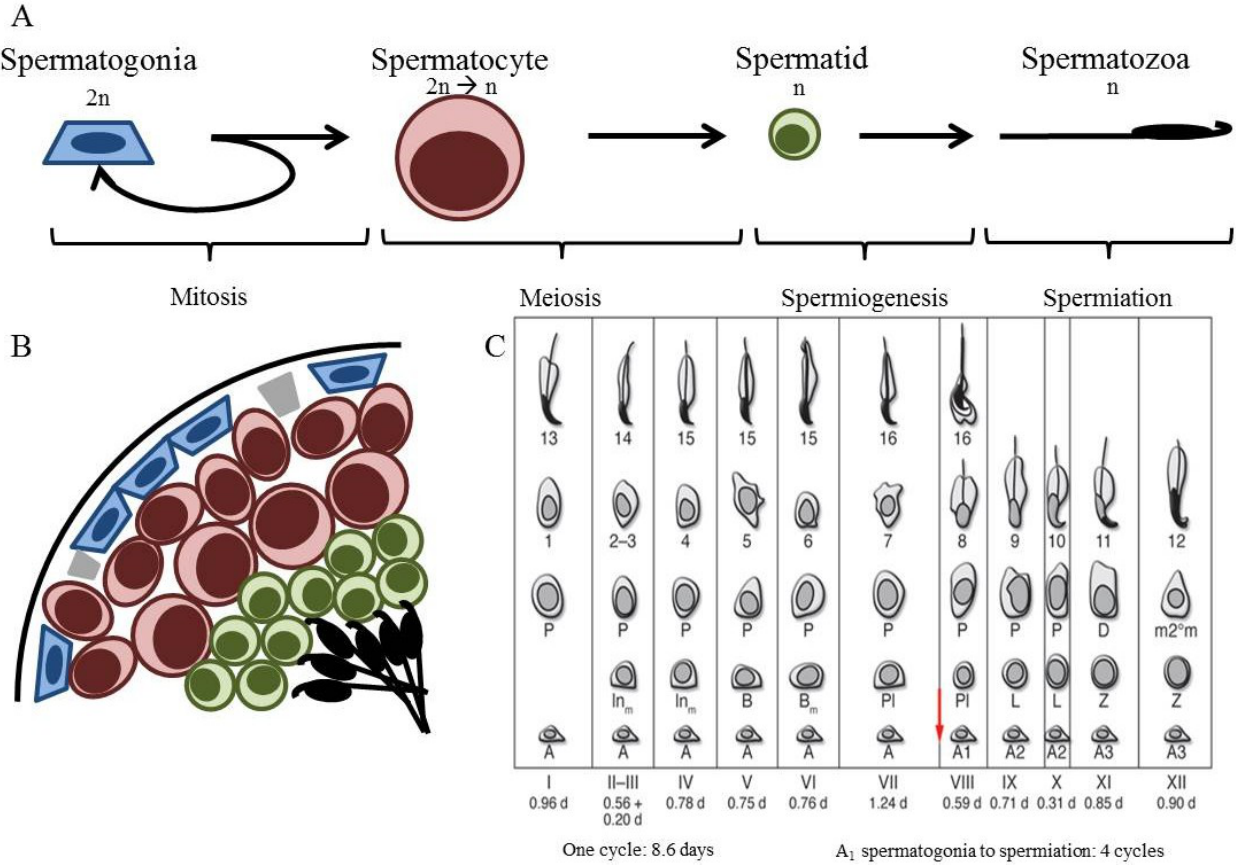
Figure 1. Overview of Murine Spermatogenesis. ( A ) Schematic representing the types of germ cells present within the seminiferous tubule. ( B ) Schematic representing the organization of the adult seminiferous tubule. Cell types in B correspond with those in A. Gray blocks represent Sertoli cell nuclei, while the white spaces between cells represent Sertoli cell cytoplasm. ( C ) Diagram depicting the twelve cellular associations present in murine spermatogenesis. The red arrow represents spermatogonial differentiation. (Figure 1C was adapted from